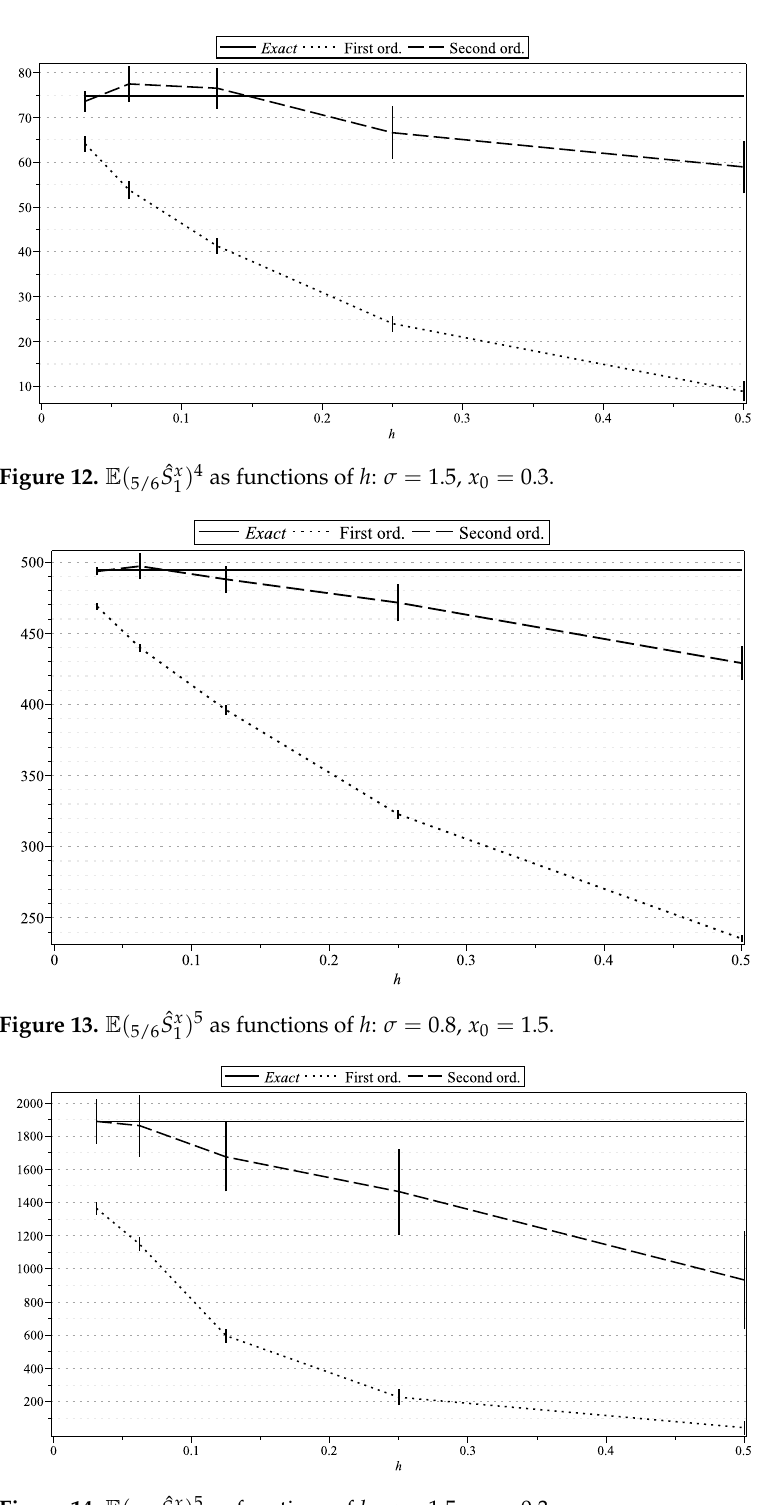
Figure 14. E ( 5/6 ˆ S x